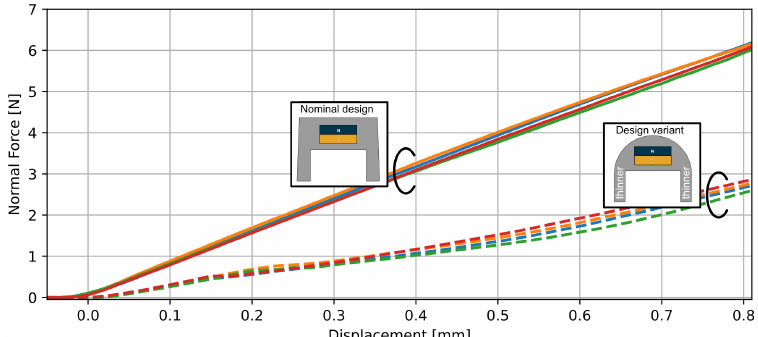
Figure 5. Force–displacement relationship for the nominal design and a design variant illustrating the different force ranges. 4 parts were tested in each case. Each part corresponds to a different color.